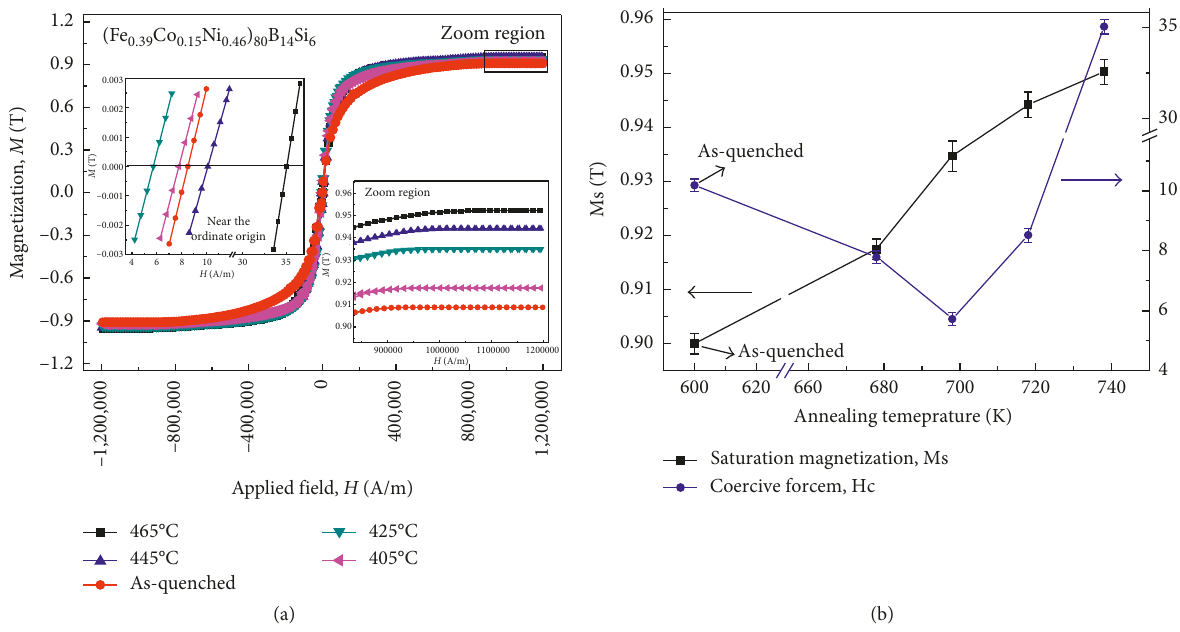
Figure 6: Dependence of magnetic hysteresis loop (a) and Ms and Hc (b) for the as-quenched (Fe annealing temperature ranging from 678K to